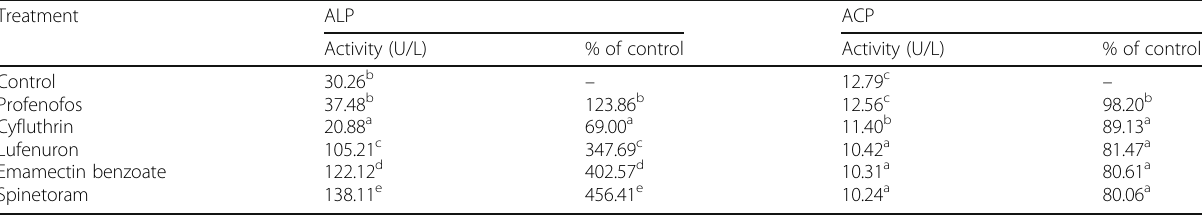
Table 2 In vivo effect of the tested compounds on the activity of AChE and GST of S. littoralis larvae Treatment